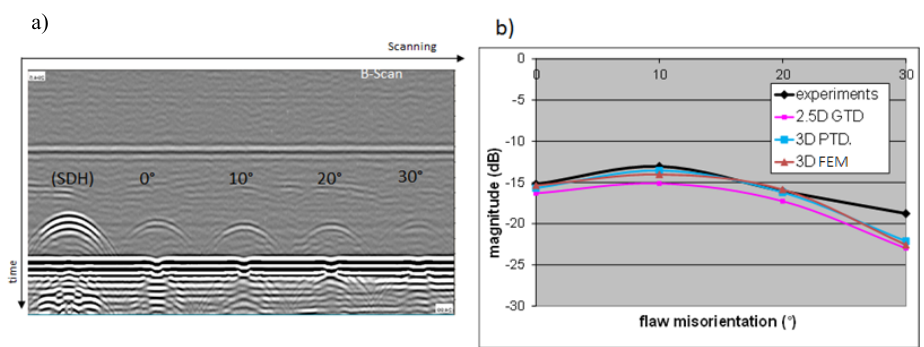
Figure 11. ( a ) Experimental B-scan obtained when scanning the side drilled hole (SDH) and the three defects (with vertical misorientation of 10° to 30° for the top edge); ( b ) validation of the 2.5D GTD, 3D PTD and the hybrid 3D FEM models against the measured echoes from the top tip of misoriented backwall breaking